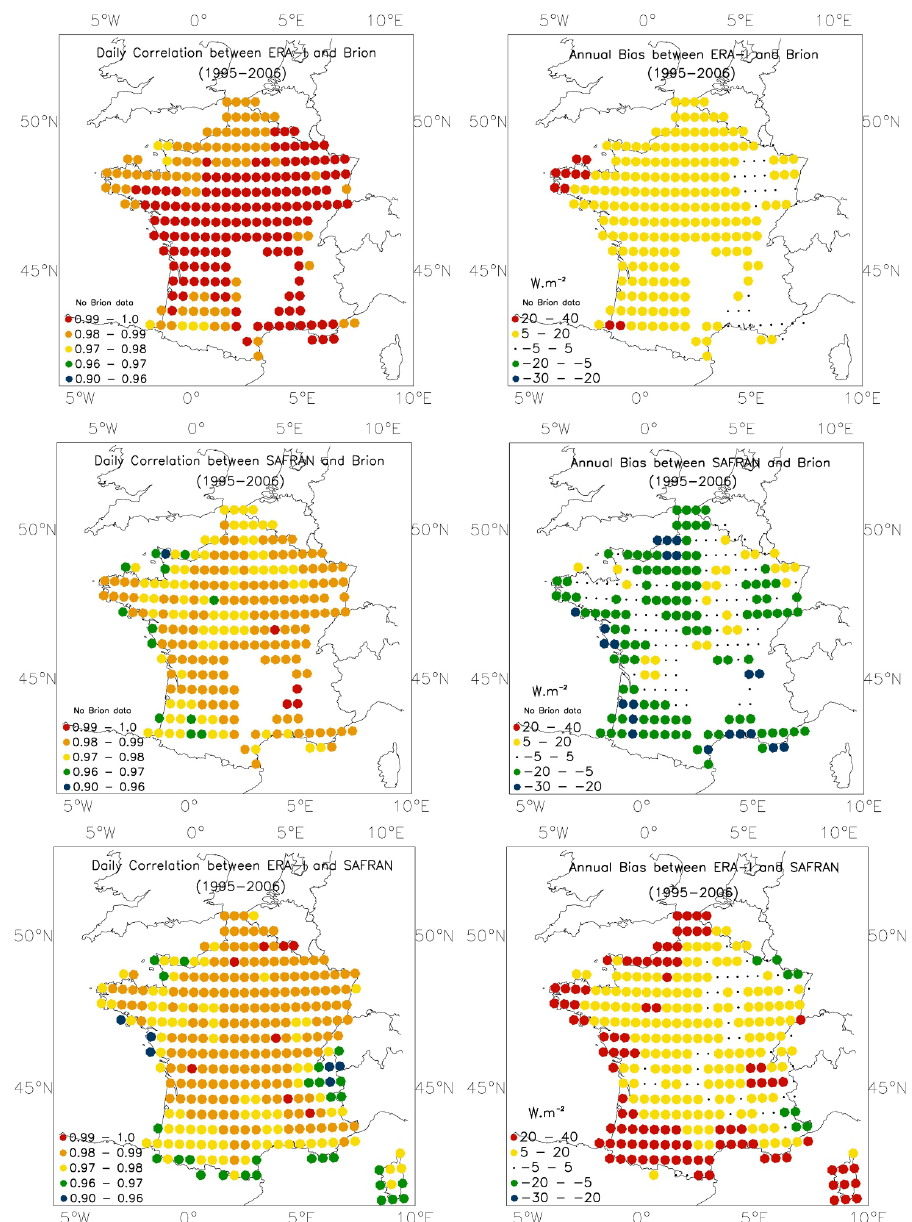
Fig. 9. Daily ISR estimates over the period 1995–2006: (top) ERA-I and (middle) SAFRAN vs. Brion and (bottom) ERA-I vs. SAFRAN in terms of (left) temporal correlation ( R 2 ) , and (right) mean